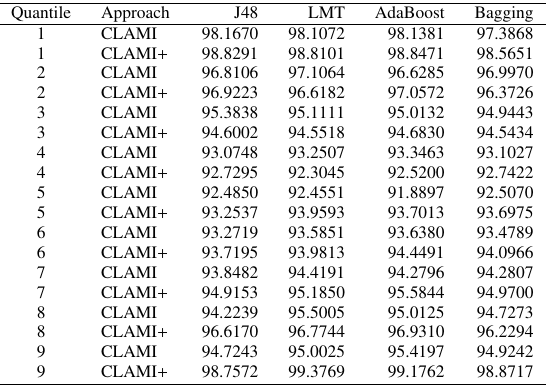
Table 1. Average Accuracy of the ML Techniques